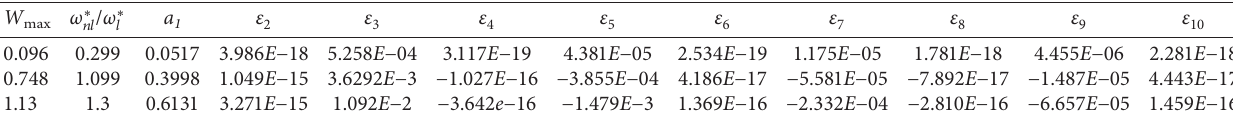
Table 3: The linear and nonlinear frequency ratio and the contribution coefficients of stepped beam (b) subjected to a forced vibration.